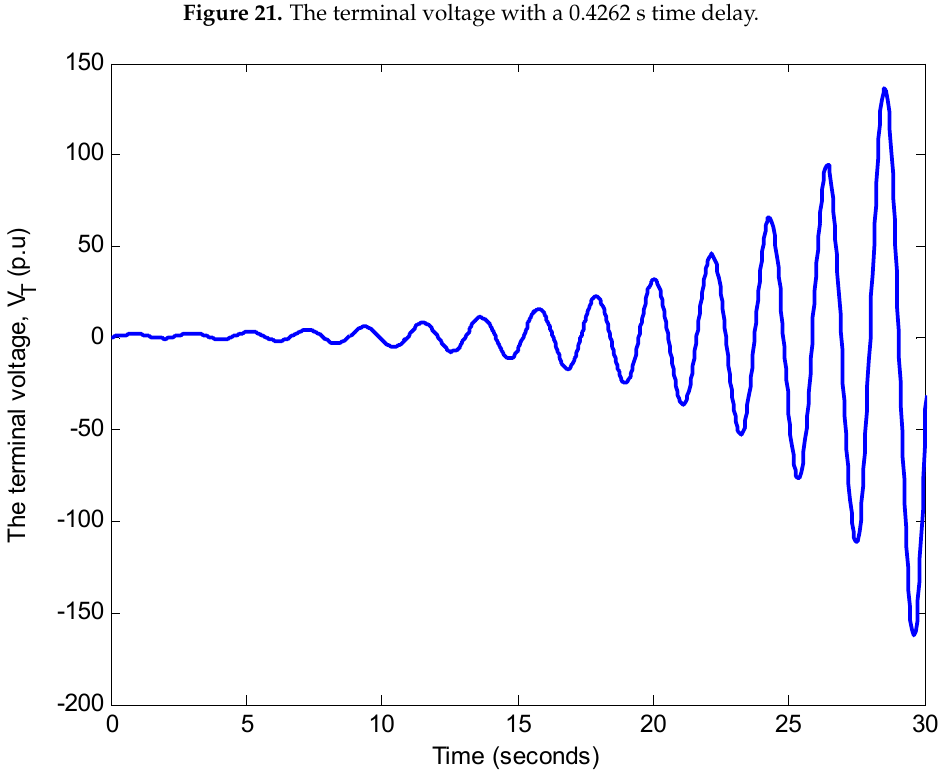
Figure 21. The terminal voltage with a 0.4262 s time delay.